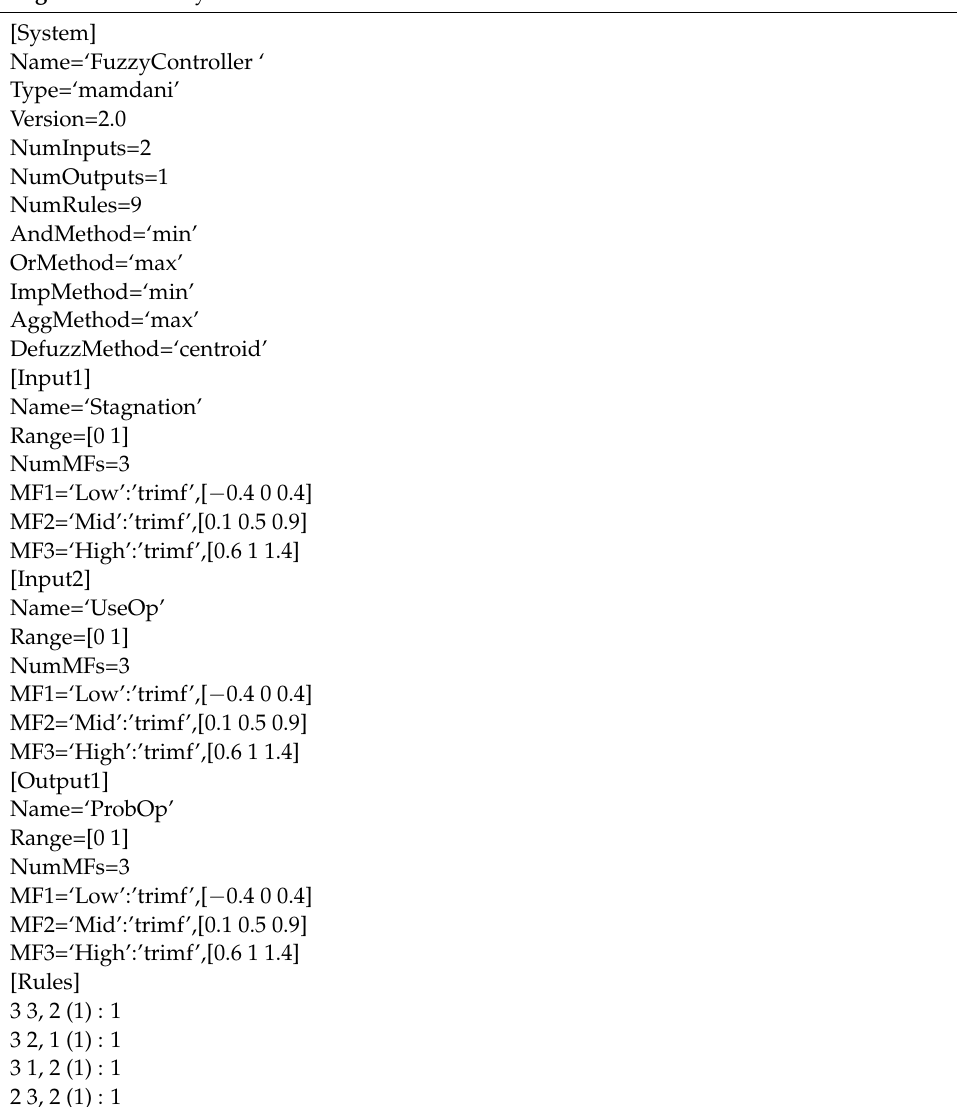
Algorithm 4. Fuzzy controller